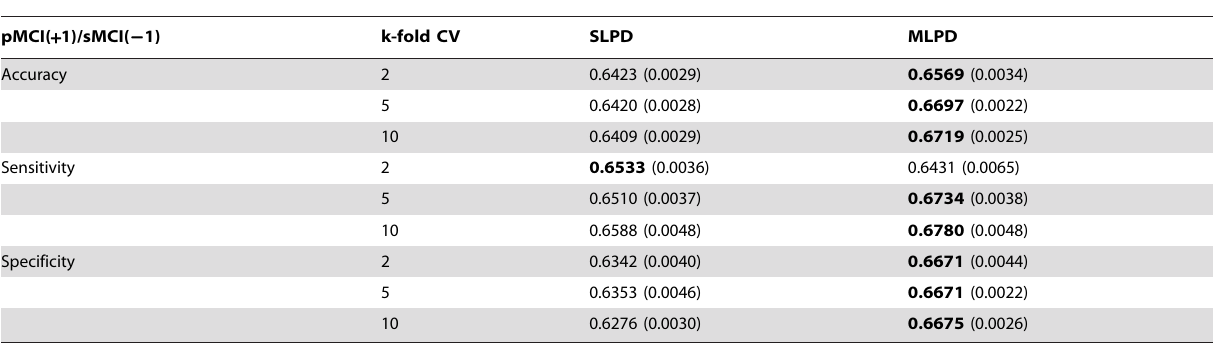
Table 4. Classification performance of MLPD and SLPD.